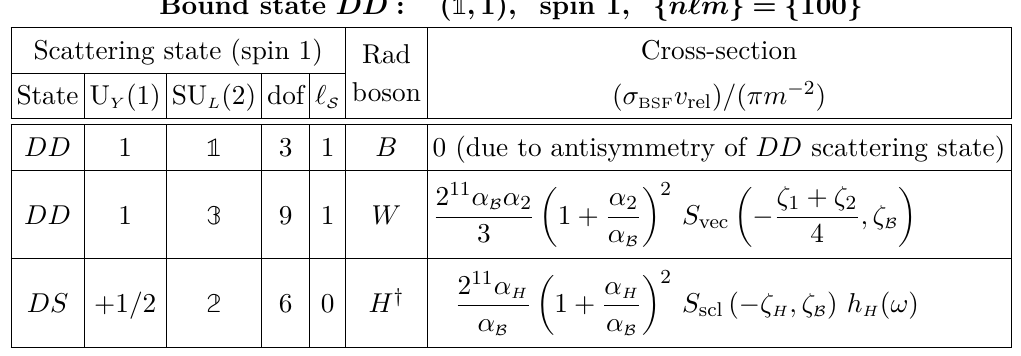
= ( − α +3 α ) / 4 , ζ = ( − ζ +3 ζ ) / 4 , 1 2 1 2 B B